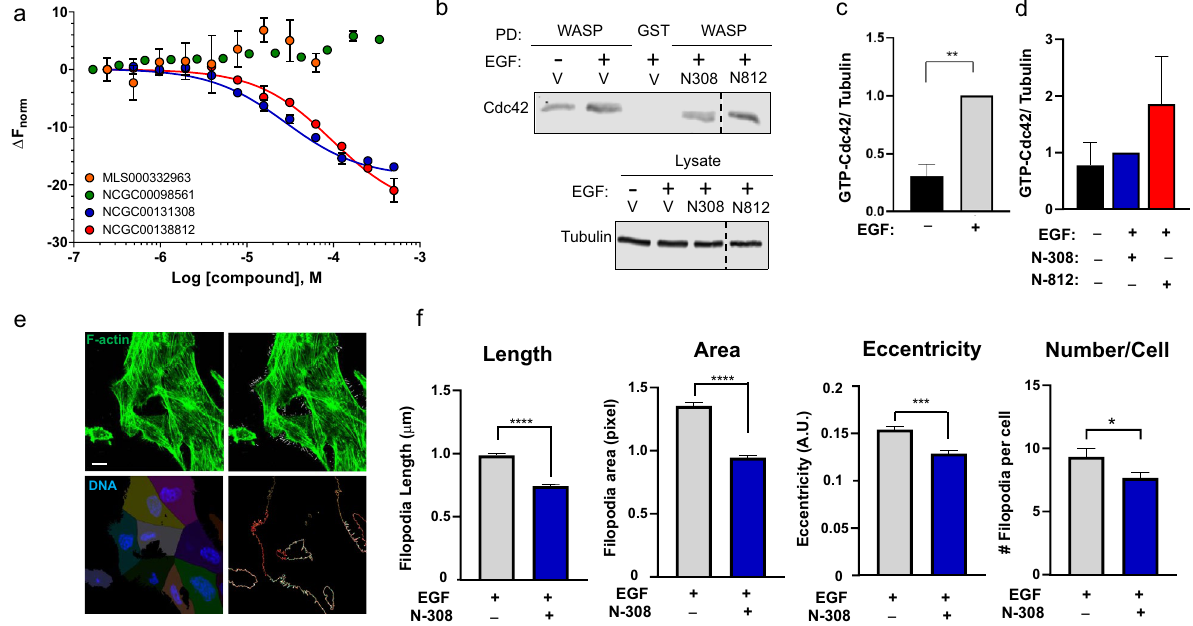
Figure 6. Interaction of selected compounds with Cdc42 and impact on Cdc42 activation. ( a ) Dose–response signals from microscale thermophoresis. Four compounds were titrated in 1:1 dilution series, starting at 500 µM (500 µM to 244 nM final concentration), and the normalized binding response (ΔFnorm) of each compound was calculated. MLS000332963 formed precipitates above 62.5 µM; these points were omitted from analysis. Data are means ± SD; n = 3. ( b ) MDA-MB-231 cells were serum starved for 16 h, then incubated with vehicle (V, DMSO), 50 µM NCGC00131308 (N308) or NCGC00138812 (N812). After 2 h, 100 ng/mL EGF ( +) or vehicle (-) was added for 10 min. After cell lysis, equal amounts of protein lysate were incubated with GST (control) or GST-WASP-GBD (WASP) for 2 h. Proteins were resolved by SDS-PAGE and probed with anti-Cdc42 antibody. Tubulin in lysates was the loading control. Dotted lines show where irrelevant lanes were removed from the blots. ( c , d ) The Cdc42 and tubulin bands were quantified and the amount of Cdc42 was corrected for tubulin in the same sample. Data are expressed as means ± SEM (n = 3). EGF-stimulated cells were set to 1 ( c ). NCGC00131308 (N308) was set to 1 ( d ). Vehicle treated samples are from the same experiments depicted in panel c ( e ) EGF-stimulated cells were stained with phalloidin (green) and Hoechst, then processed by confocal microscopy. White spikes depict individual filopodia ( upper right panel ). Cells were segmented by Voronoi tessellation using nuclei as seed points ( lower left panel ). Exposed cell membranes were segmented ( lower right panel ). Scale bar, 10 μm ( f ) Filopodia geometric parameters were quantified, including branch length (Length), cumulative area (Area), the ratio of minor and major axis length of the bounding box of each filopodial segment (Eccentricity), as well as number of filopodia per cell. At least fifty cells were analyzed. Data are expressed as means ± SEM (error bars) from three separate experiments, each conducted in triplicate. Unpaired Student’s t-test : * p < 0.05; ** p < 0.01 ***; p < 0.001; **** p <